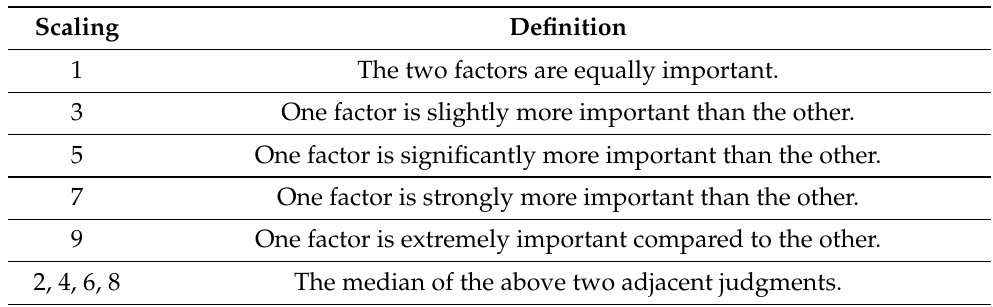
Table 5. Judgment matrix scaling method